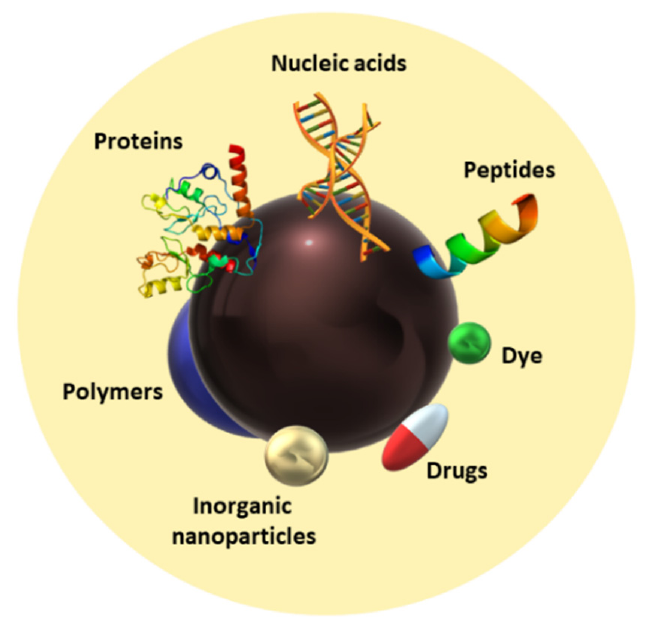
Figure 1. Schematic illustration of MNCs with different coatings, target ligands, drugs, etc. Molecules can be embedded in the coating or adsorbed on the surface.